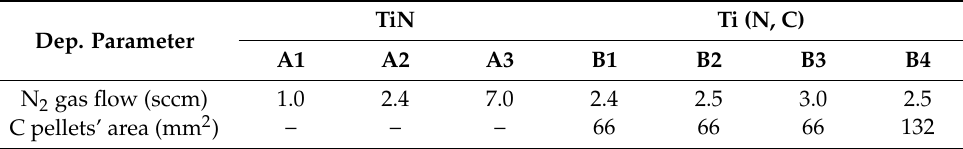
Table 1. Parameters of DC reactive sputtering deposition process of TiN and Ti (N, C) films. The N 2 gas flow can be converted to SLPM, taking the conversion factor of × 10 − 3 . For instance, for the A1 films, the N 2 gas flow is 1.0 × 10 − 3 SPLM. TiN Ti (N, Dep. Parameter